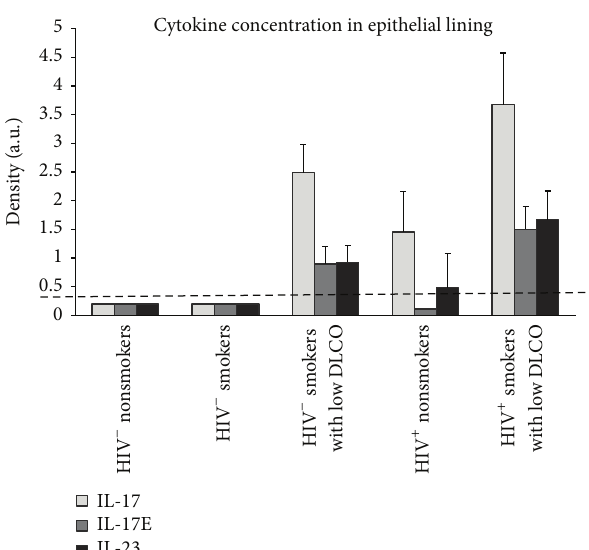
Figure 1: The levels of Th17 cytokines in epithelial lining fluid were analyzed with the Proteome Profiler (cid:2) Human Cytokine Array Panel and average values of HIV1 − healthy nonsmokers ( 𝑛 = 6 ), HIV1 − healthy smokers ( 𝑛 = 7 ), HIV1 − smokers with low DLCO ( 𝑛 = 6 ), HIV1 + nonsmokers ( 𝑛 = 4 ), and HIV1 + smokers with low DLCO ( 𝑛 = 4 ) are presented in the graph.